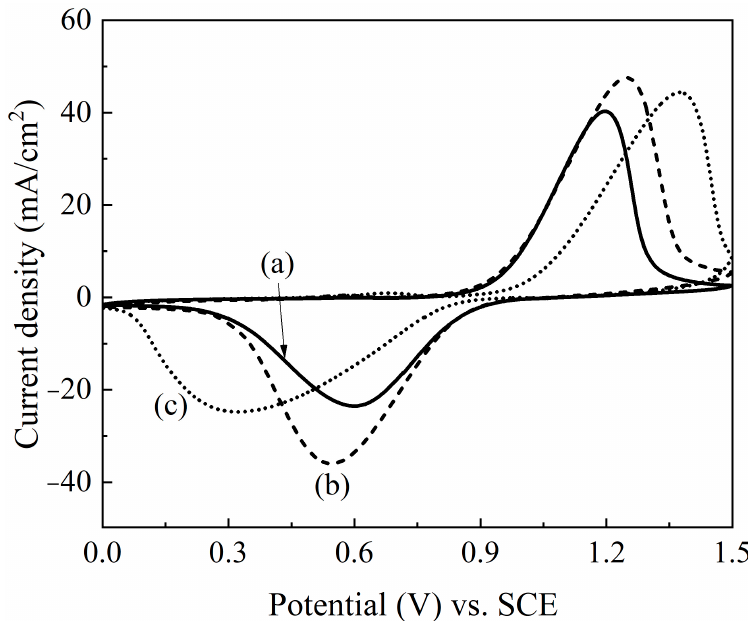
Figure 7. CV test curves of prepared electrodes at a scan rate of 5 mV/s, (a) pristine GF, (b) APPJ- coated polydopamine on GF, and (c) soaking GF in polydopamine solution.